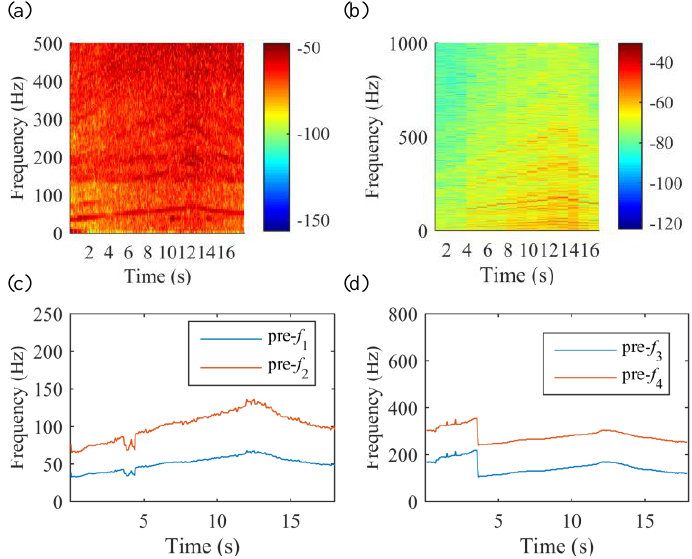
Figure 13. Inner race fault case: ( a ) TFR of lower frequency band signal, ( b ) TFR of envelope of resonant frequency band signal, ( c ) extracted IF ridges from ( a ) using FPO, and ( d ) extracted IF ridges from ( b ) using FPO.